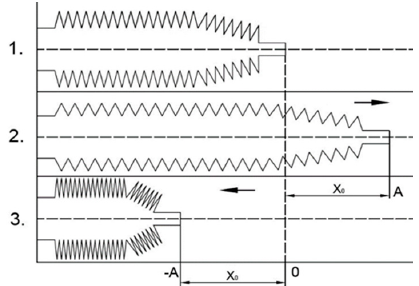
Figure 3. The drawing of a cuff in three characteristic positions (1—cuff in an unloaded state, 2— maximally elongated, 3—maximally compressed, X 0 —amplitude).